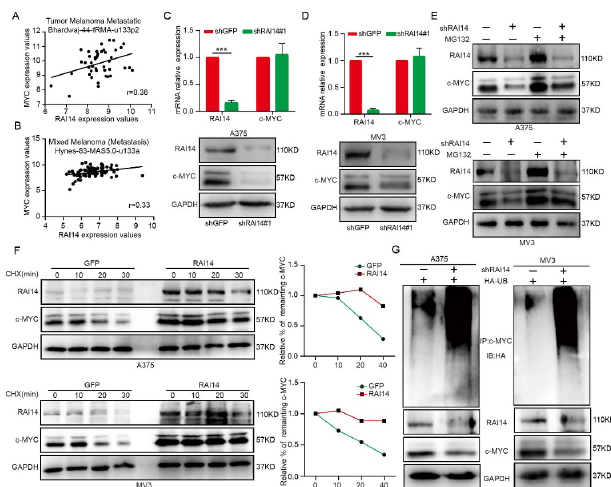
Figure 3. RAI14 regulates the stability of c-MYC by regulating c-MYC ubiquitination. ( A , B ) Correla- tion between RAI14 and c-MYC was analyzed by database analysis. ( C , D ) The mRNA and protein of c-MYC were detected by qRT-PCR and Western blot assay. ( E ) Cells were treated with MG132 for 8 h to detect the protein level of c-MYC. ( F ) The effect of RAI14 expression on the turnover rate of c-MYC was explored by treating the RAI14 overexpression group and the control group with CHX with a time gradient (0 min, 10 min, 20 min, 30 min). The gray value was calculated by ImageJ. ( G ) Specific plasmids were transfected into cells, after 40 h, the transfected cells were treated with MG132 for 8 h. The ubiquitinated c-MYC proteins were pulled down with an anti-c-MYC antibody. The data were expressed as mean ± SD. Student’s t test was performed to analyze significance. *** p < 0.001.